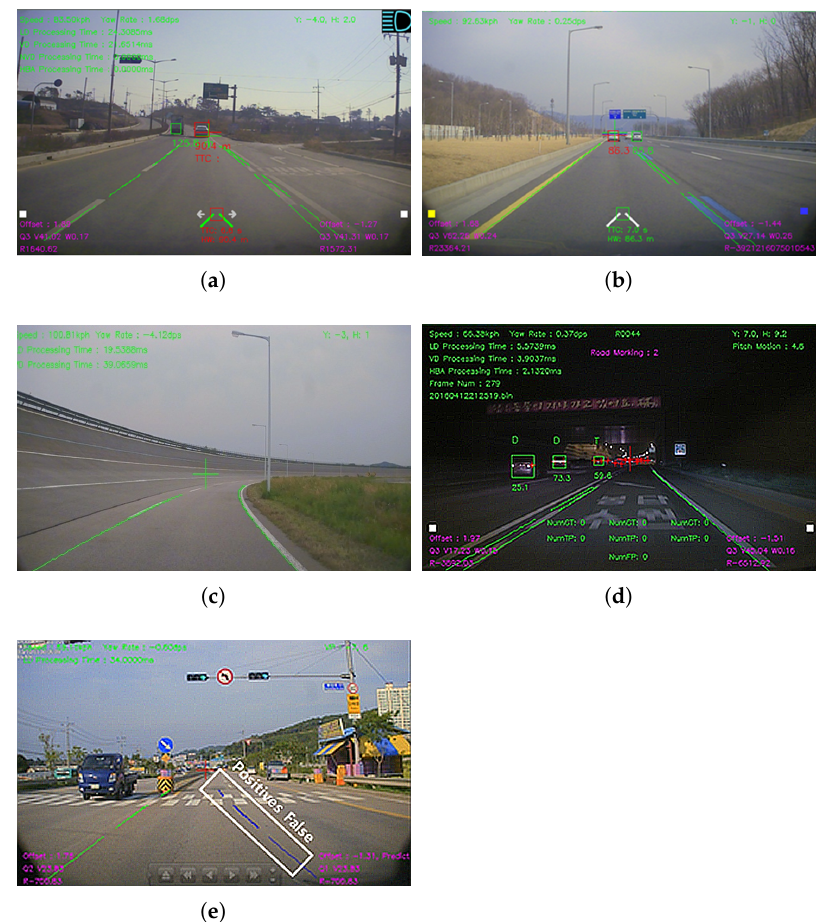
Figure 21. Real-road tests were performed under different lane types: ( a ) dashed line + dashed line, ( b ) solid line + dashed line, ( c ) curved line, ( d ) road marking line, and ( e )